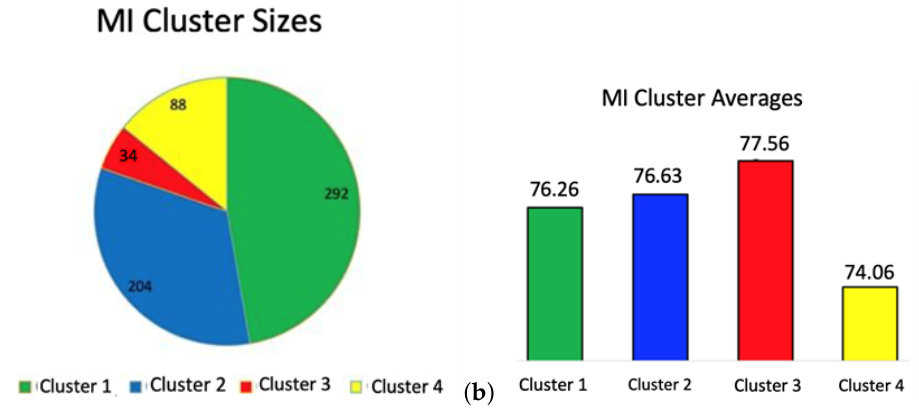
Figure 4. ( a ) MI clusters’ sizes; ( b ) MI clusters’ average grades. Table 3. Size, Average Final Grade, and Standard Deviation of clusters formed with MI dimensions. Cluster 1 Cluster 2 Cluster 3 Cluster 4 292 204